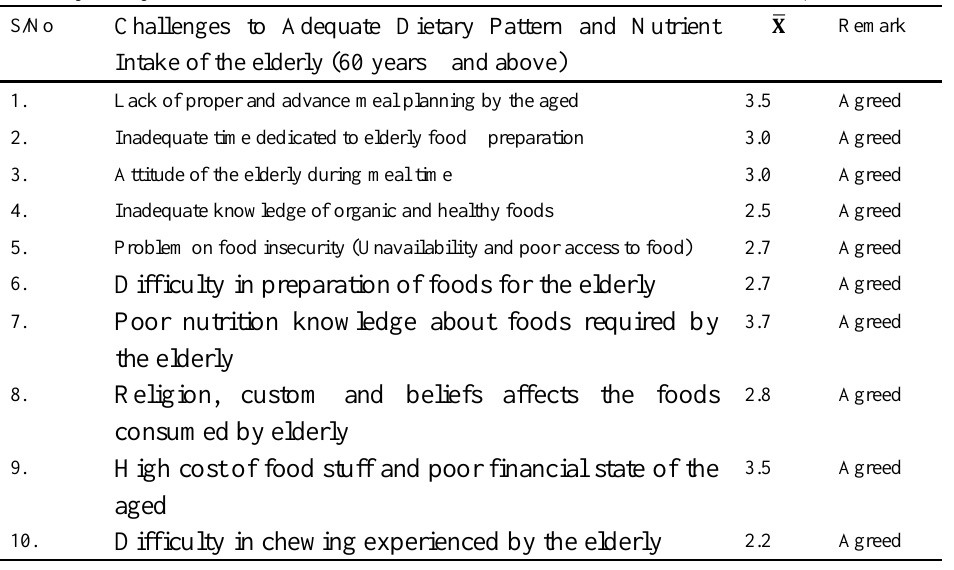
Table 1: Mean Responses on the challenges to adequate dietary pattern and nutrient intake of the elderly (60 years and above) in Idemili North Local Government Area, Anambra state